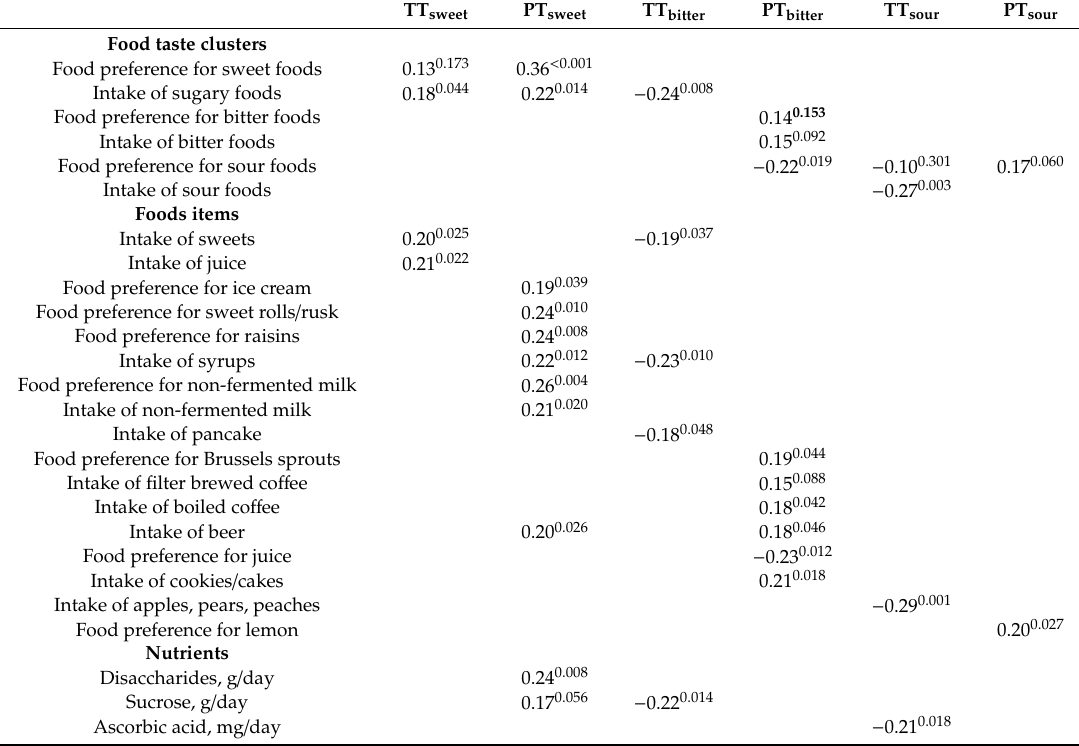
Table 3. Spearman correlation coe ffi cients between taste recognition threshold (TT) and preference (PT) and food preference scores or intake frequencies in sweet, bitter, sour taste categories, as well as food items and nutrients associated with any of the three taste categories. P-values are shown in superscript. A full list of correlations is presented in Table